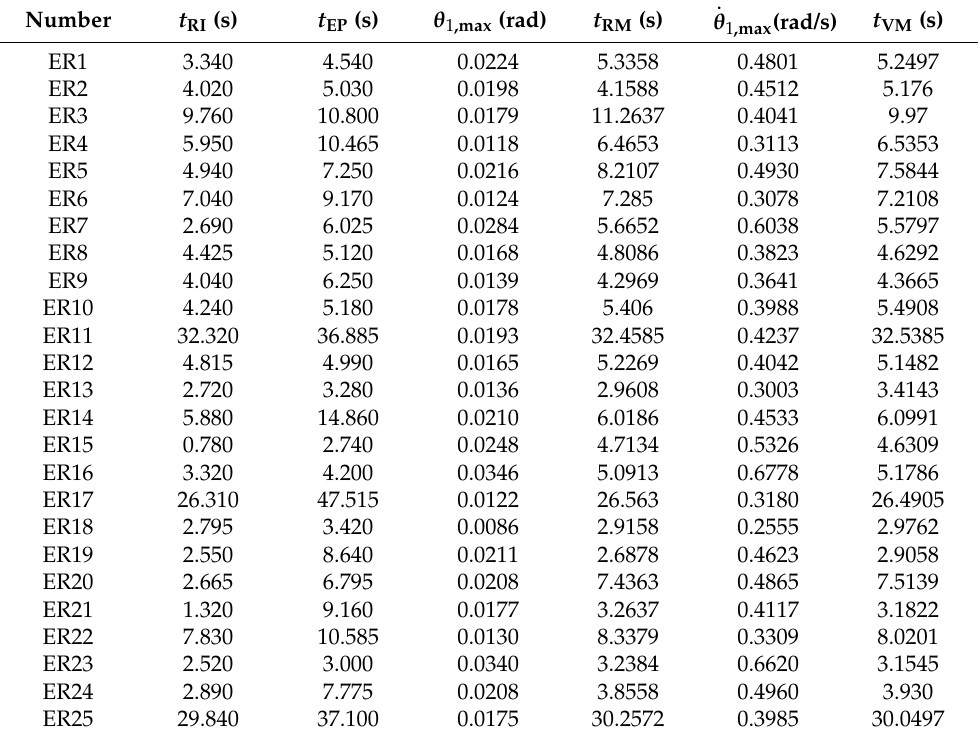
Table 3. Time history analysis results of seismic